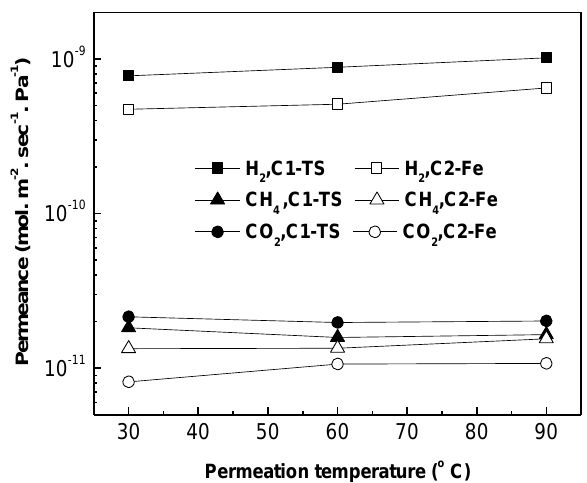
Figure 13. H 2 , CH 4 and CO 2 permeance as a function of permeation temperature for sample C1-TS#16 (close symbols) and C2-Fe#18 (open symbols).